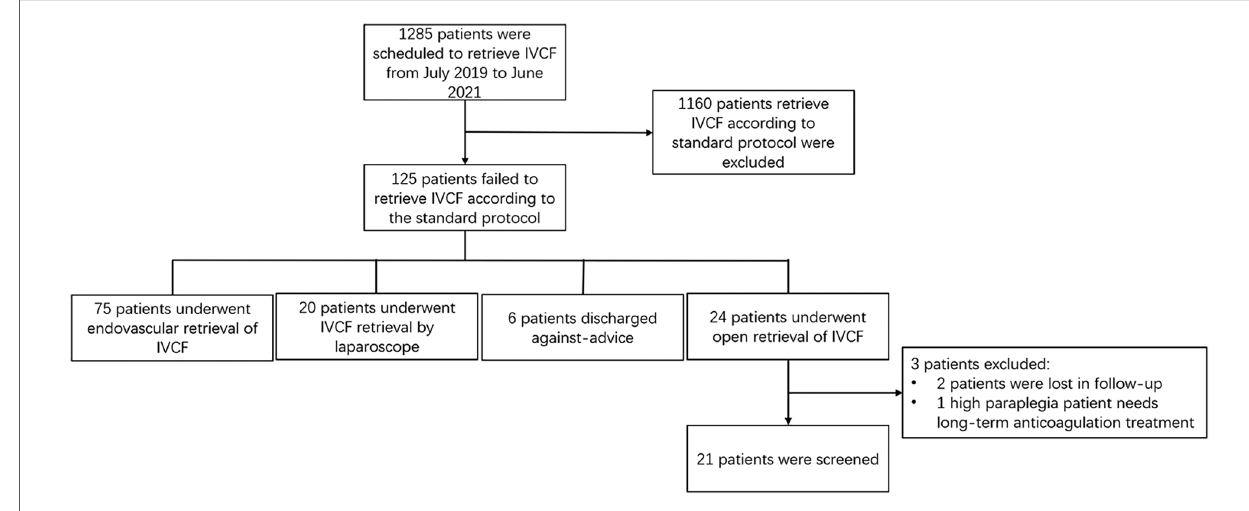
FIGURE 1 Flow chart of patients who choose open surgery to remove inferior vena cava fi